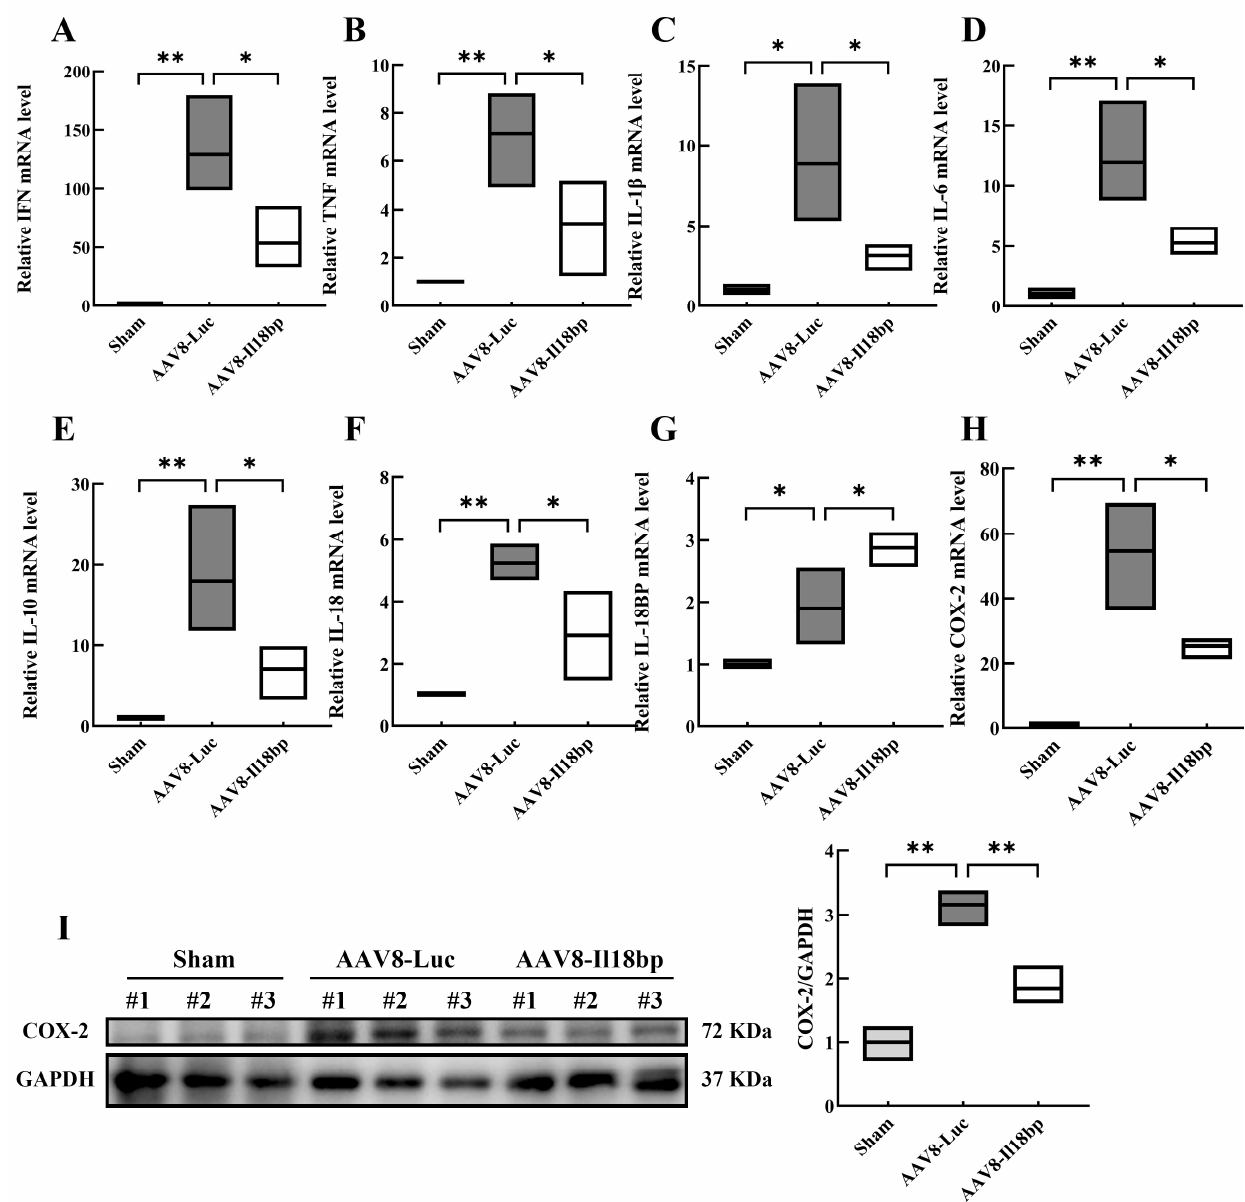
Figure 2. mRNA levels of inflammatory factors in different groups. ( A – E ) Compared with the sham group, levels of IFN, TNF, IL-1β, IL-6, and IL-10 mRNA were significantly increased in allografts after donor pretreatment with AAV8-Luc. However, levels of IFN, TNF, IL-1β, IL-6, and IL-10 mRNA were significantly lower in allografts after donor pretreatment with AAV8-Il18bp. ( F ) The level of IL-18 mRNA was significantly increased after OLTx with AAV8-Luc, and infection of AAV8-Il18bp could decrease the IL-18 mRNA level. ( G ) The level of IL-18BP mRNA was significantly increased after OLTx with AAV8-Luc, and infection of AAV8-Il18bp could also increase the IL-18BP mRNA level. ( H ) The level of COX-2 mRNA was analyzed by qRT-PCR. ( I ) Western blotting analysis of COX-2 in liver tissue after sham or OLTx in different groups. Results represent the mean ± SEM ( n = 3 per group); * p < 0.05; ** p < 0.01.